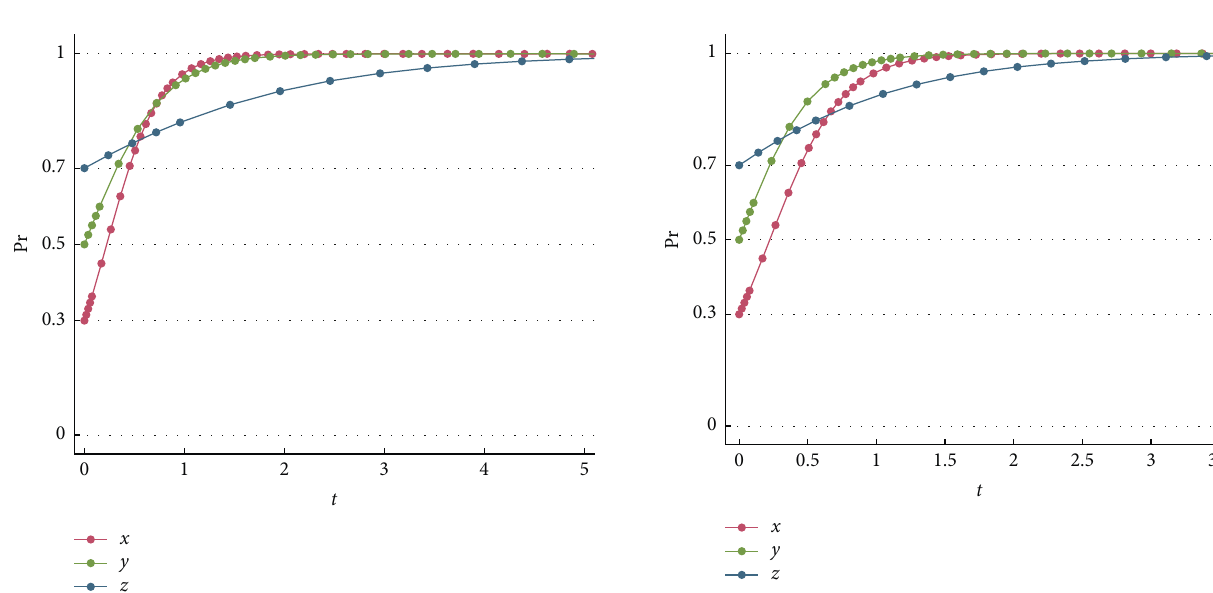
8 (1, 1, 1) with punishment